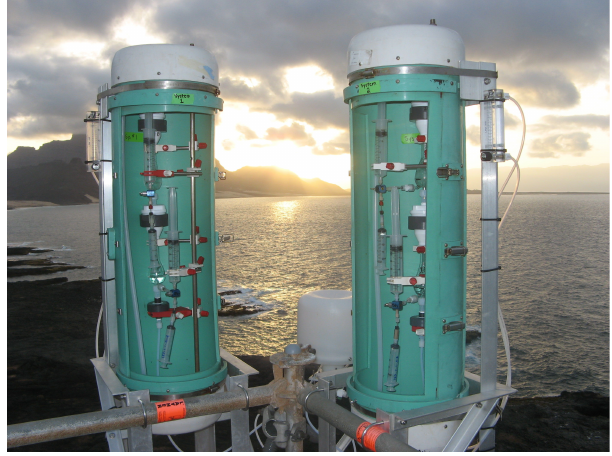
Figure 3. Mist chambers at the Cape Verde sampling